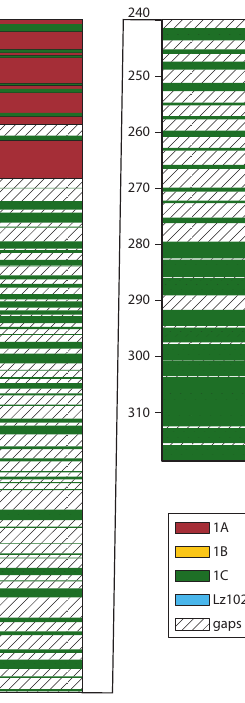
Figure 2. Core composite profile of the lacustrine basin infill of Lake El’gygytgyn illustrating the origin of the interval used from holes 1A, 1B, and 1C and pilot core Lz1024. Shaded section are gaps in the composite